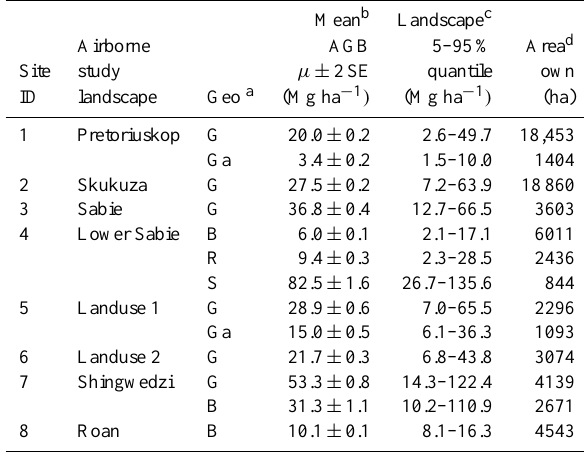
Table 1. Airborne-estimated mean biomass and landscape variation in AGB (0.5 ha per